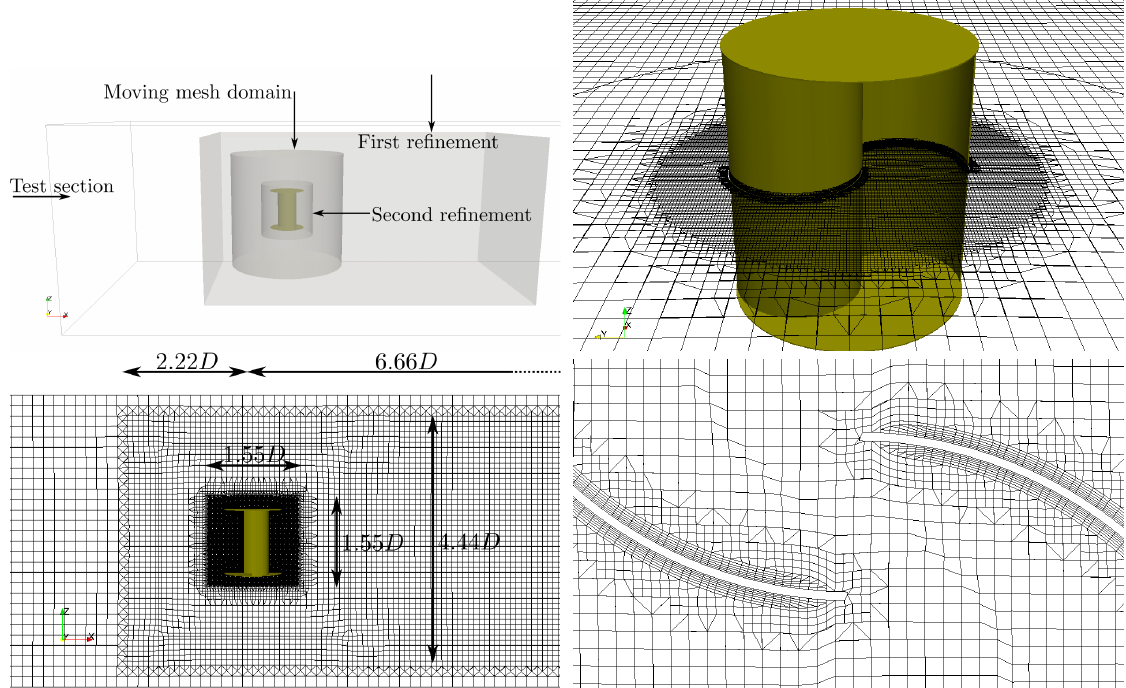
Figure 5. Three-dimensional view of a section within the chamber domain ( top-left ), a zoom of the mesh around the turbine ( top-right ), a vertical section showing the different refinement levels of the mesh topology ( bottom-left ) and cross-section in the wall vicinity ( bottom-right ).